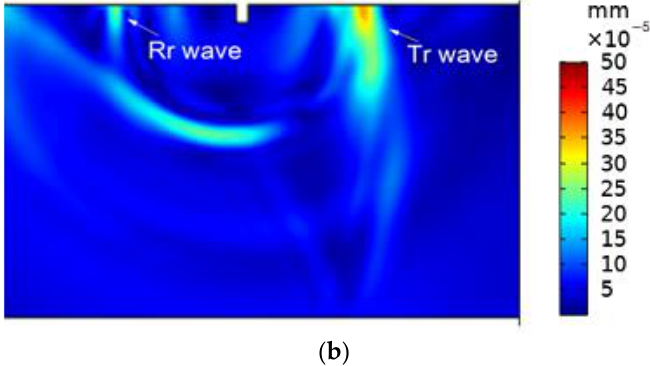
Figure 4. Laser ultrasonic propagation images. ( a ) t = 1.33 μs. ( b ) t = 3.34 μs.